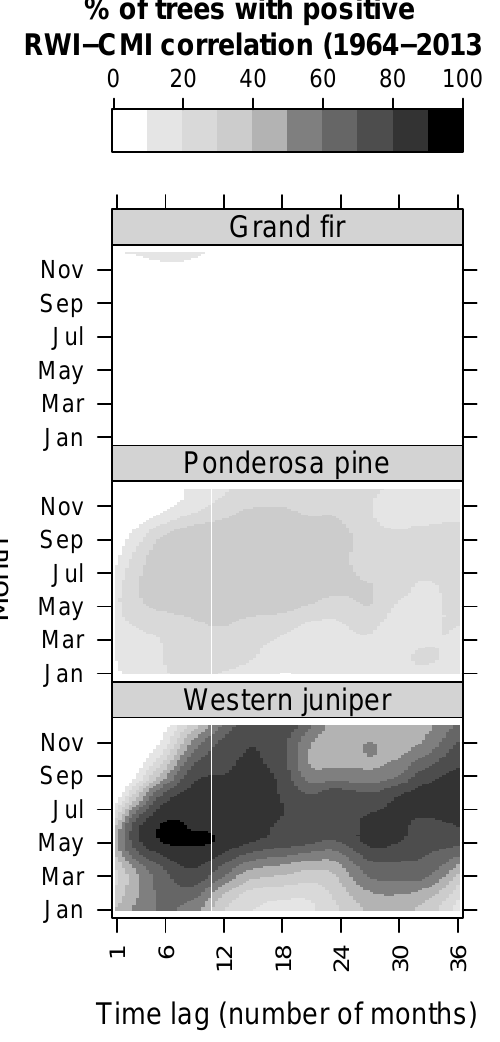
Figure 4. Correlations between annual tree radial growth and the climate moisture index (CMI = PPT–ET 0 ) from 1964 to 2013 for three tree species in the eastern Cascades, Oregon. Depicted is the proportion of trees with a significant positive correlation be- tween annual ring-width indices (RWI) and CMI calculated for each month at time lags extending from 1 to 36 months. See Fig. S1 and Table S6 for correlations between RWI and additional climate vari- ables.